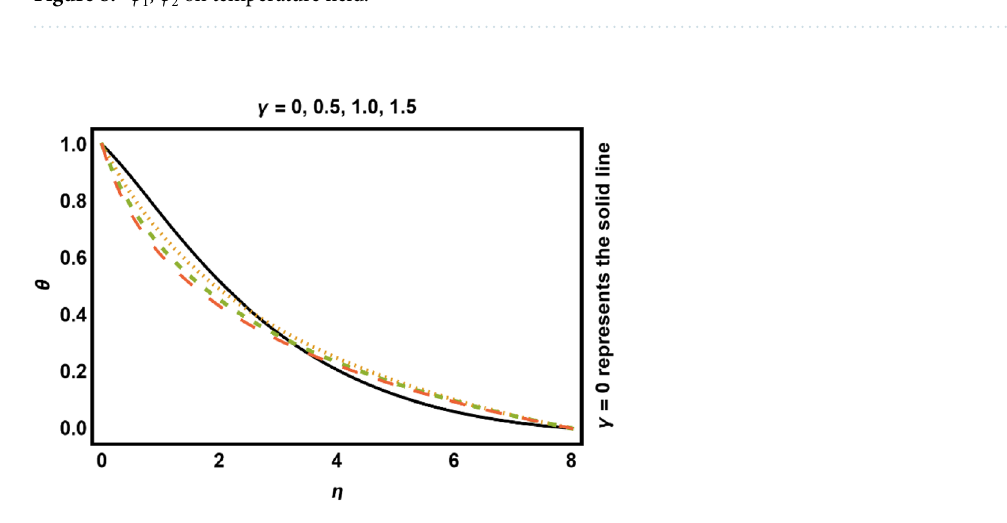
Figure 9. γ on fluids